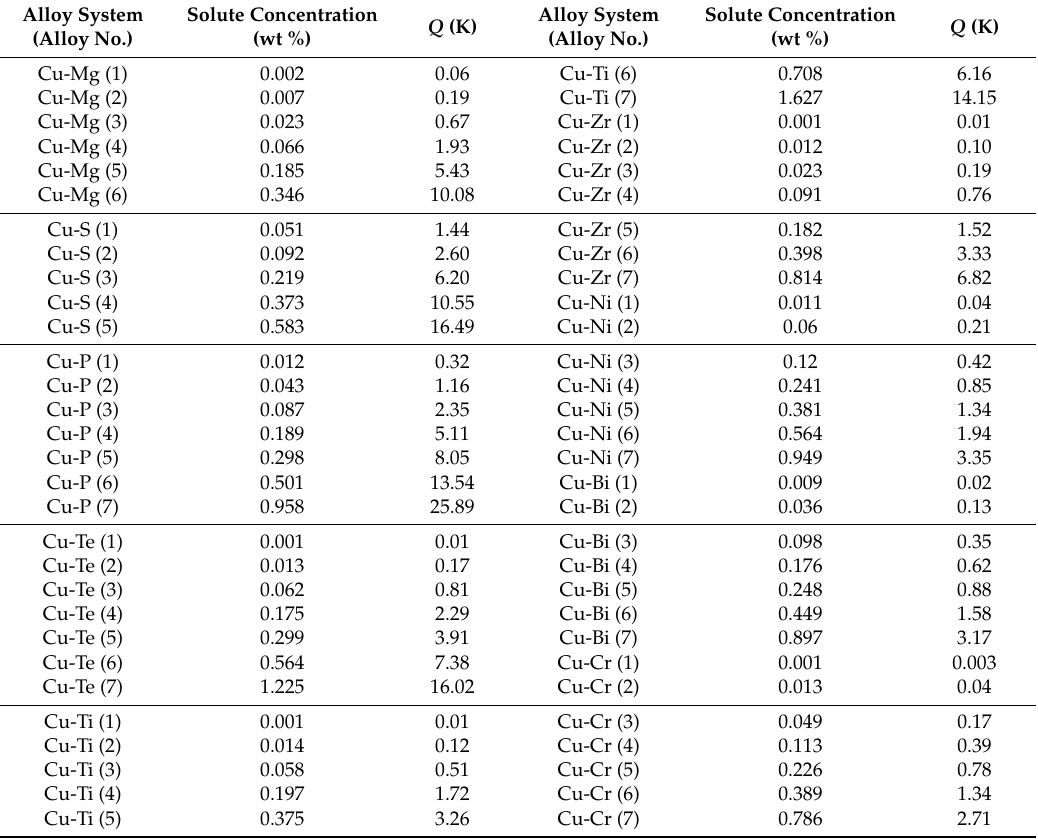
Table 2. Data of Q and alloy concentration (main alloying element) of TP-1 samples cooled after transfer to the